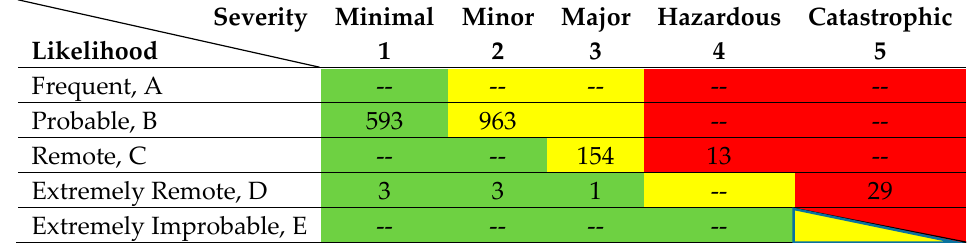
Table 15 . Risk matrix with look ‐ ahead time 120 s, overtaking scenario.05 Table 15 . Risk matrix with look-ahead time 120 s, overtaking scenario. Table 15 . Risk matrix with look-ahead time 120 s, overtaking scenario. Table 15. Risk matrix with look-ahead time 120 s, overtaking scenario. Table 15 . Risk matrix with look-ahead time 120 s, overtaking scenario.